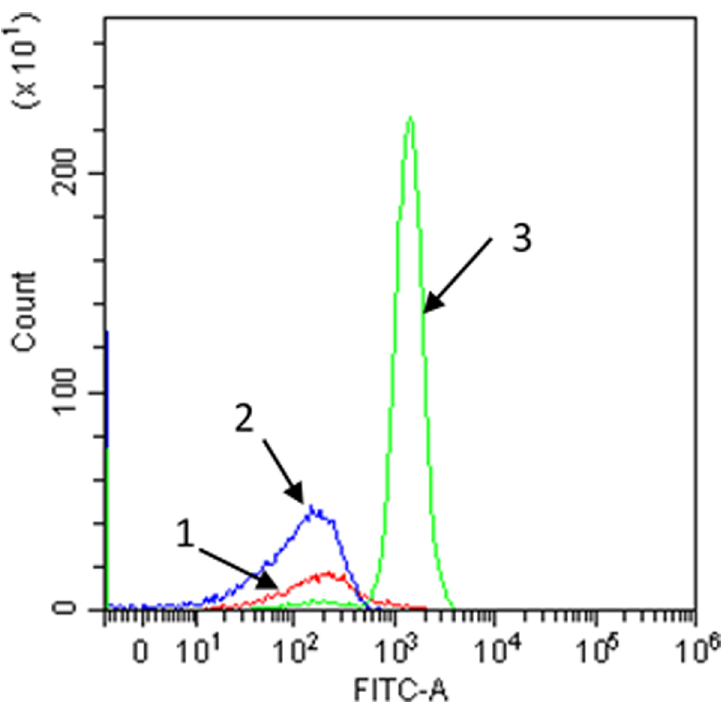
Fig 1. Representative fluorescence histogram data of GFP-P17 and P17 in water. The x-axis shows green (FITC) fluorescence intensity, and the y-axis shows the number of events recorded for a corresponding fluorescence intensity. 1, water sample without cells; 2, water sample with P17; 3, water sample with GFP-P17.